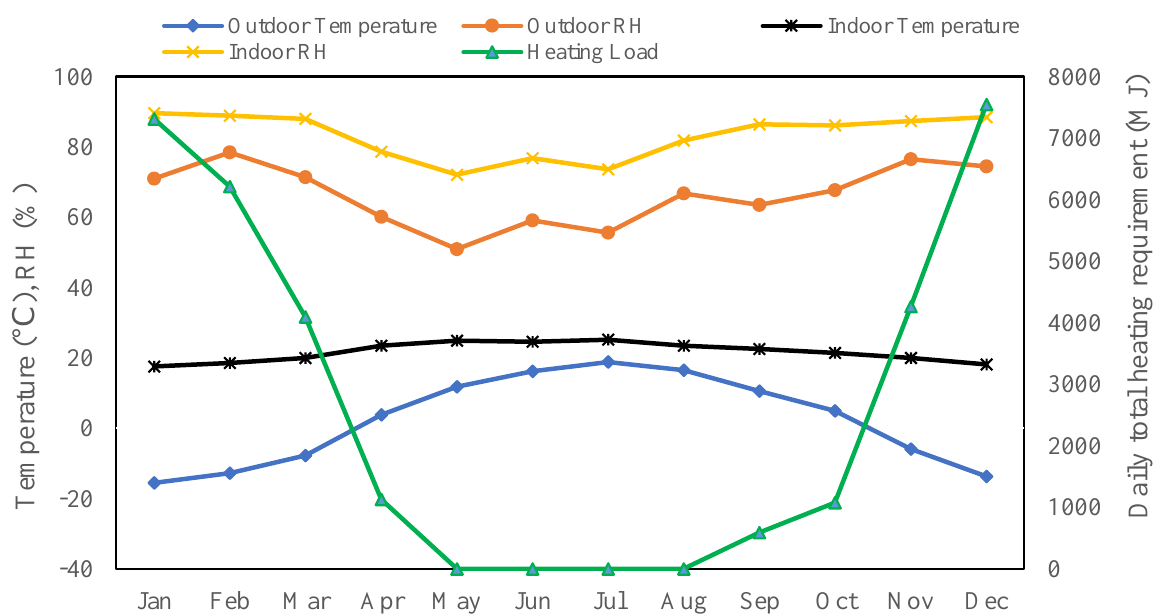
Figure 11. Monthly average thermal environment and heating requirement in the CSG located in Saskatoon.